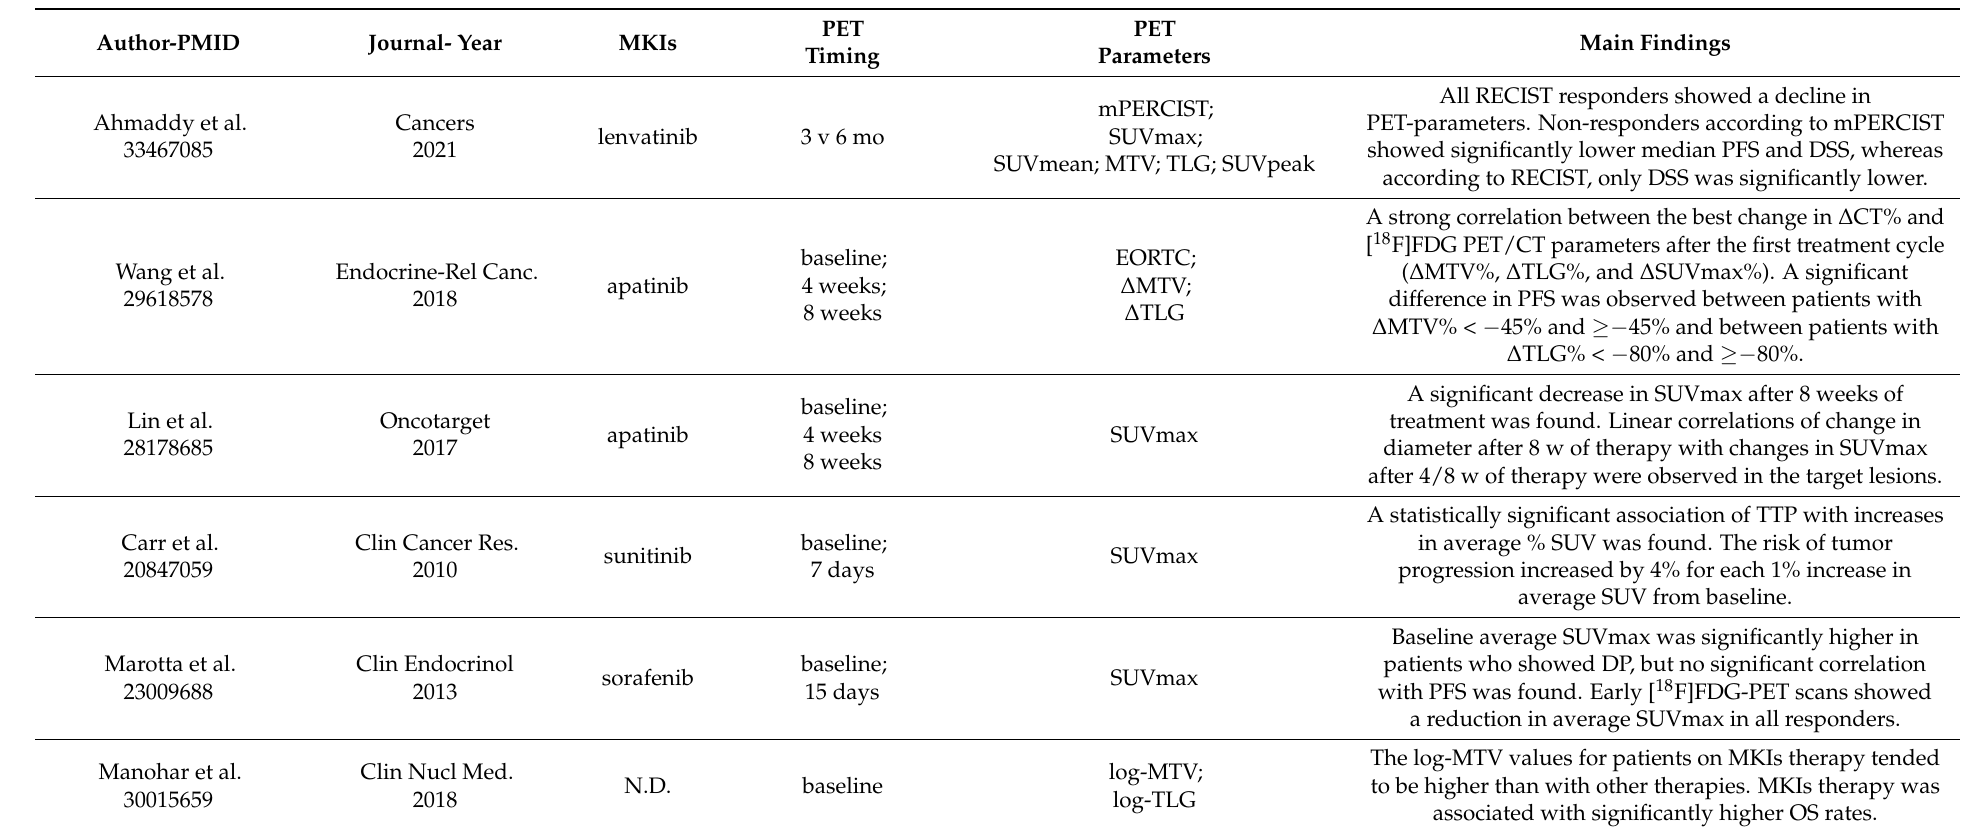
Table 1. Characteristics of the original articles